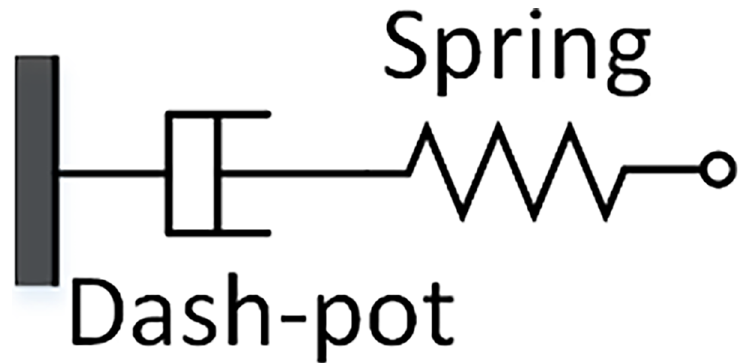
Fig 1. Viscous Dash-pot and linear spring lumped element model connected in